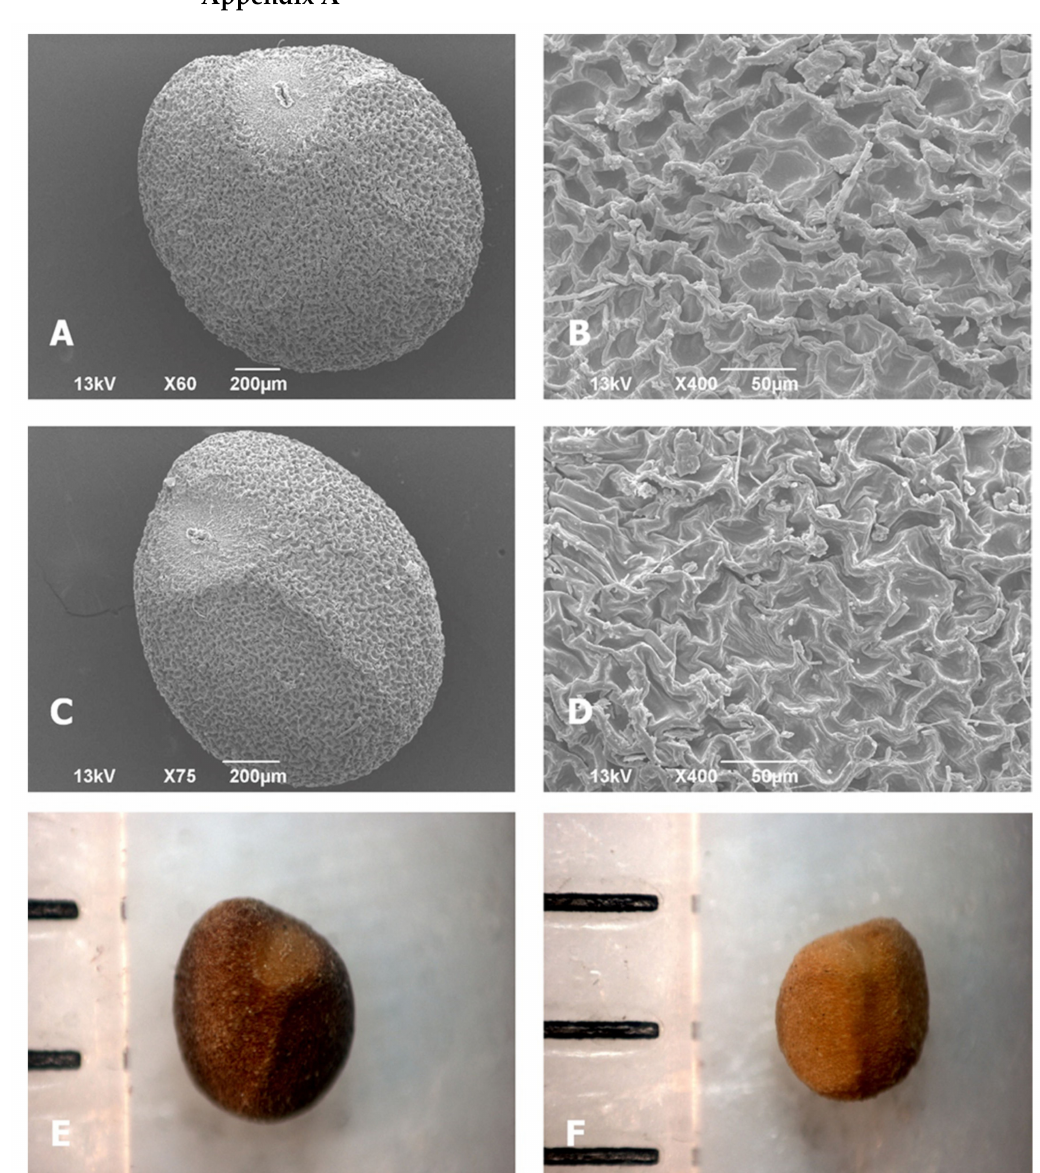
Figure A1. Cuscuta campestris seed: ( A , C ) SEM photographs of seed shape; ( B , D ) cell shape in the epidermal layer of seed coat; ( E , F ) LM photographs of seed color.